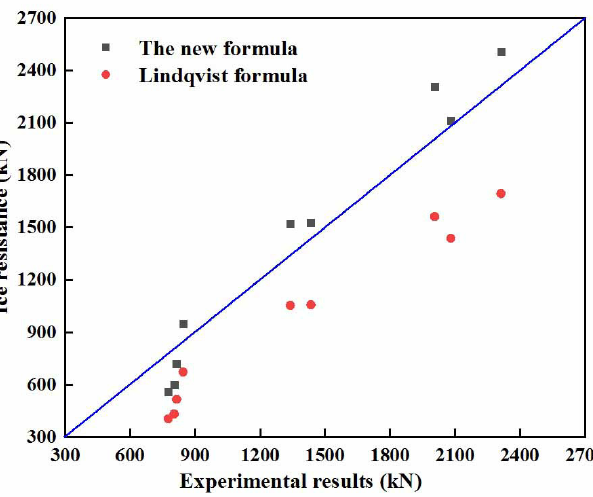
Figure 7. Comparison of experimental and calculated results for the icebreaker KV Svalbard.